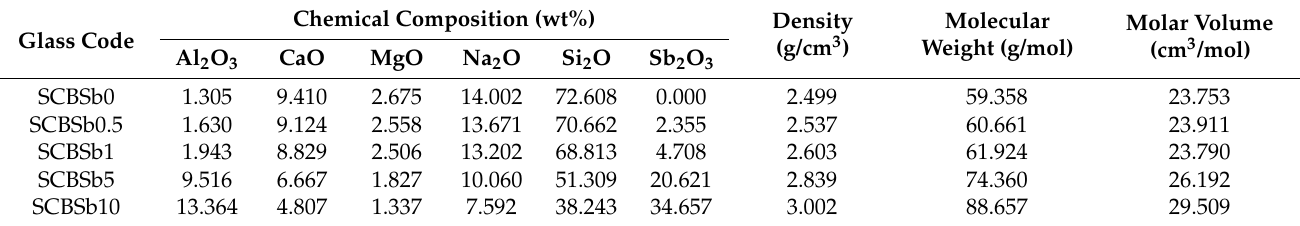
Molecular (g/cm 3 ) Weight (g/mol)